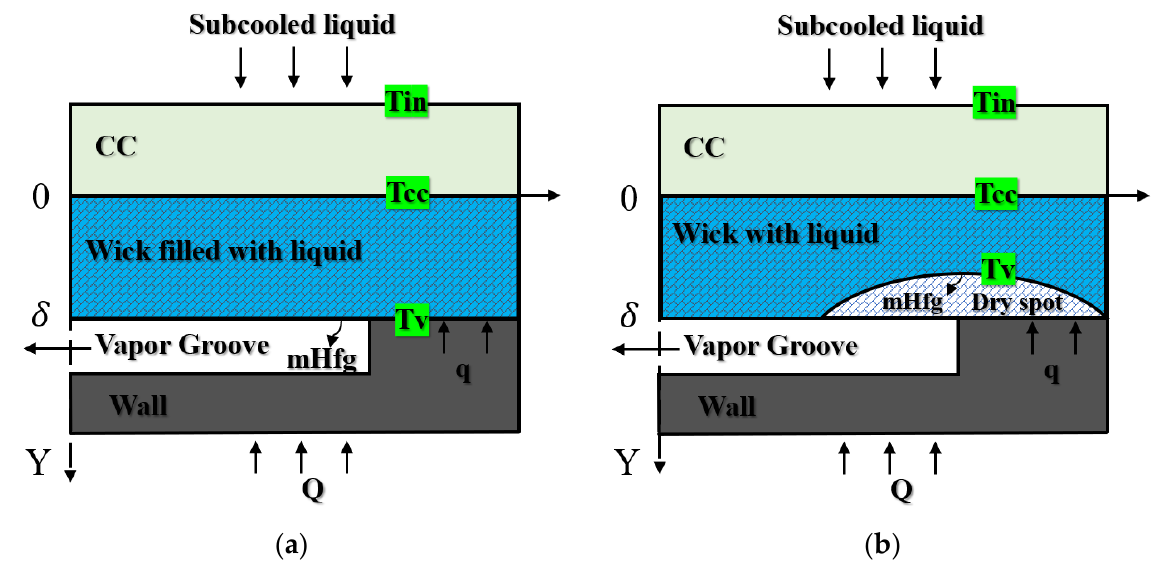
Figure 4. Schematic of the computational domain: ( a ) The capillary wick is completely saturated with liquid at low heat flux, and the evaporation process occurs at the wick – groove interface. ( b ) Vapor penetrates into the wick, which blocks liquid feeding and causes a partial dry-out spot in the wick at high heat